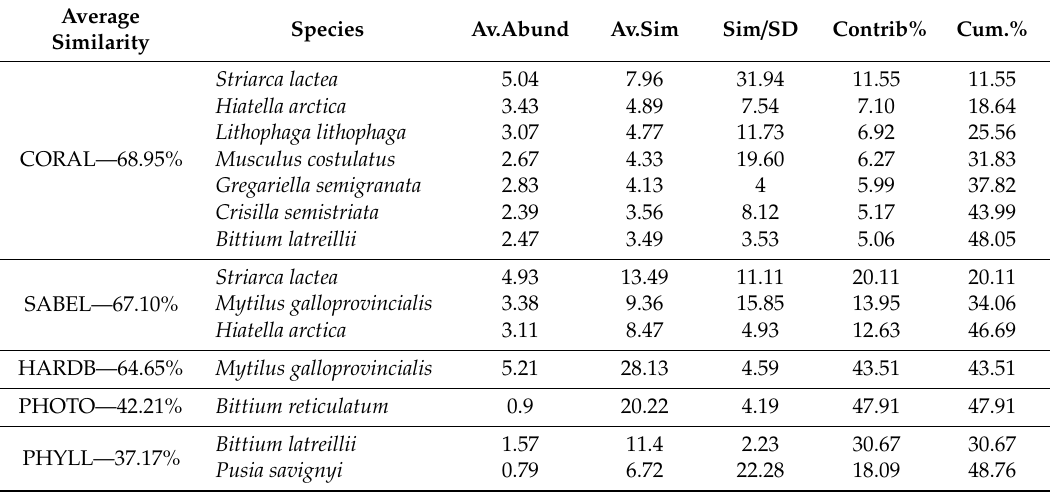
Table 5. Results of the SIMPER analyses, showing dominant species mostly responsible for the similarity among replicates for each habitat. (Cum%-50% cut-o ff